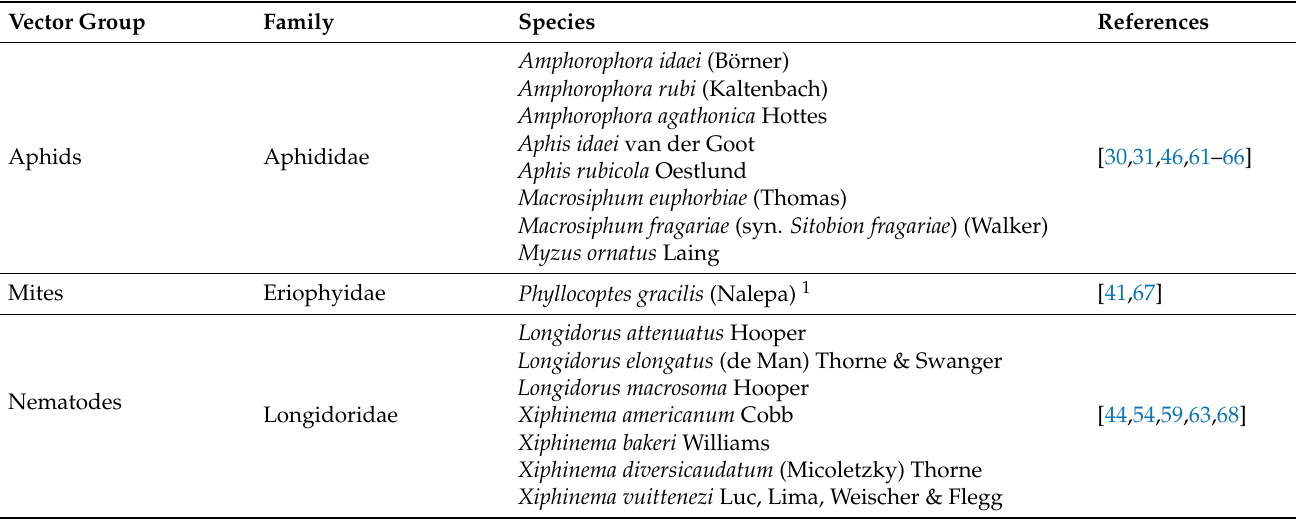
Table 2. Known invertebrate vectors of raspberry ( Rubus idaeus )